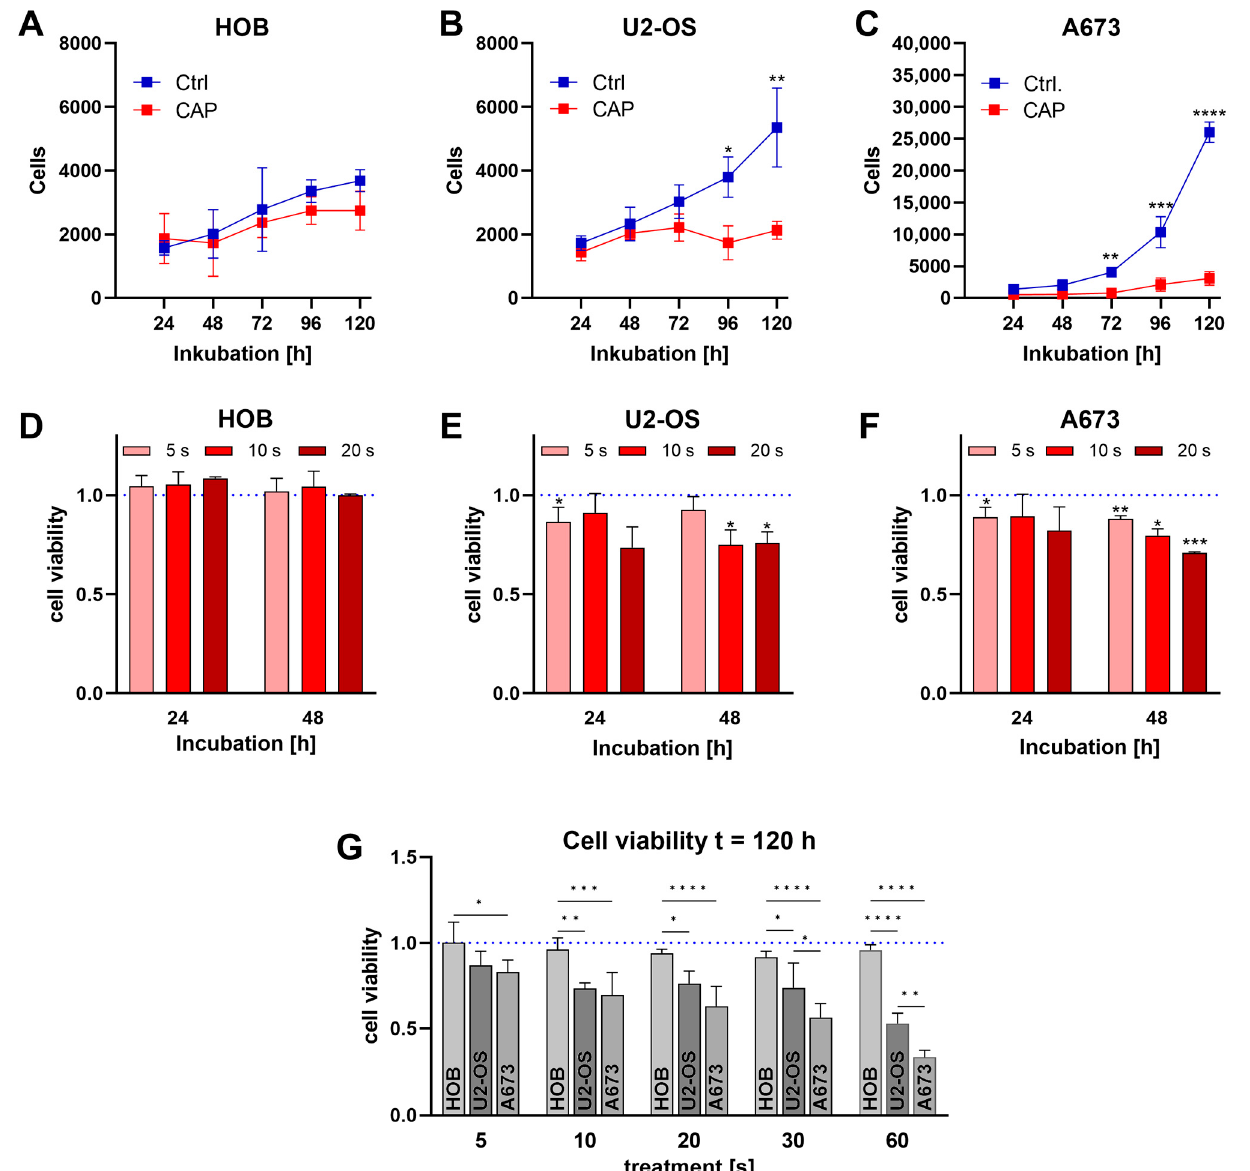
Figure 2. Human osteoblasts (HOB) and bone cancer cells (U2-OS and A673) were treated with cold atmospheric plasma (CAP). During the 120 h incubation, the cell count was determined every 24 h using a CASY Cell Counter and Analyzer ( A – C ). After CAP treatment, the non-malignant and the cancer cells were treated for 24 h, 48 h ( D – F ), and 120 h ( G ). Cell viability was determined using a titer blue assay. Mean values ± SD were normalized to the control treatments. Significant differences are indicated as follows * p < 0.05, ** p < 0.01, *** p < 0.001, **** p < 0.0001.